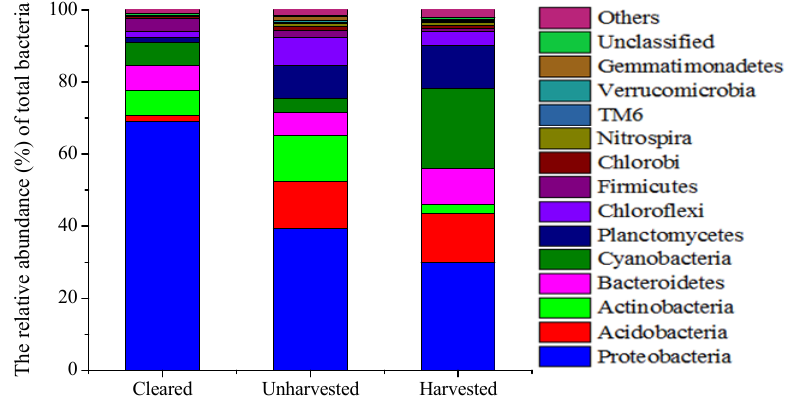
Figure 3. The relative abundance (%) of total bacteria for different groups by phylum.